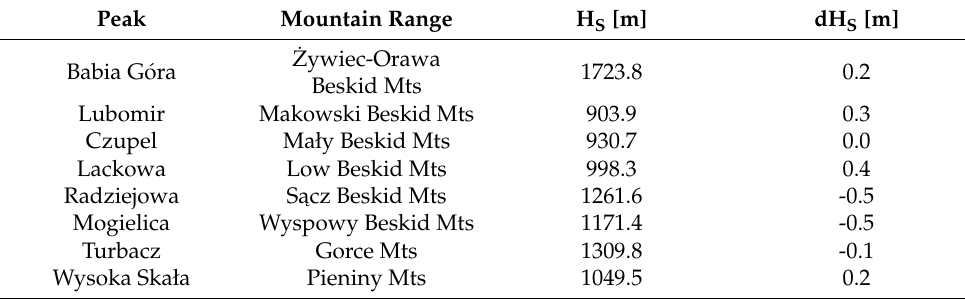
Table 7. Measurement results obtained with the Xiaomi Mi 8 smartphone.